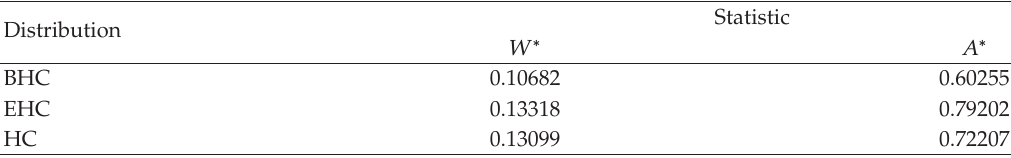
Table 2: Goodness-of-fit